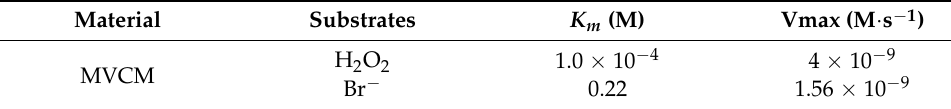
Table 1. Kinetic parameters for the MVCM haloperoxidase mimic.